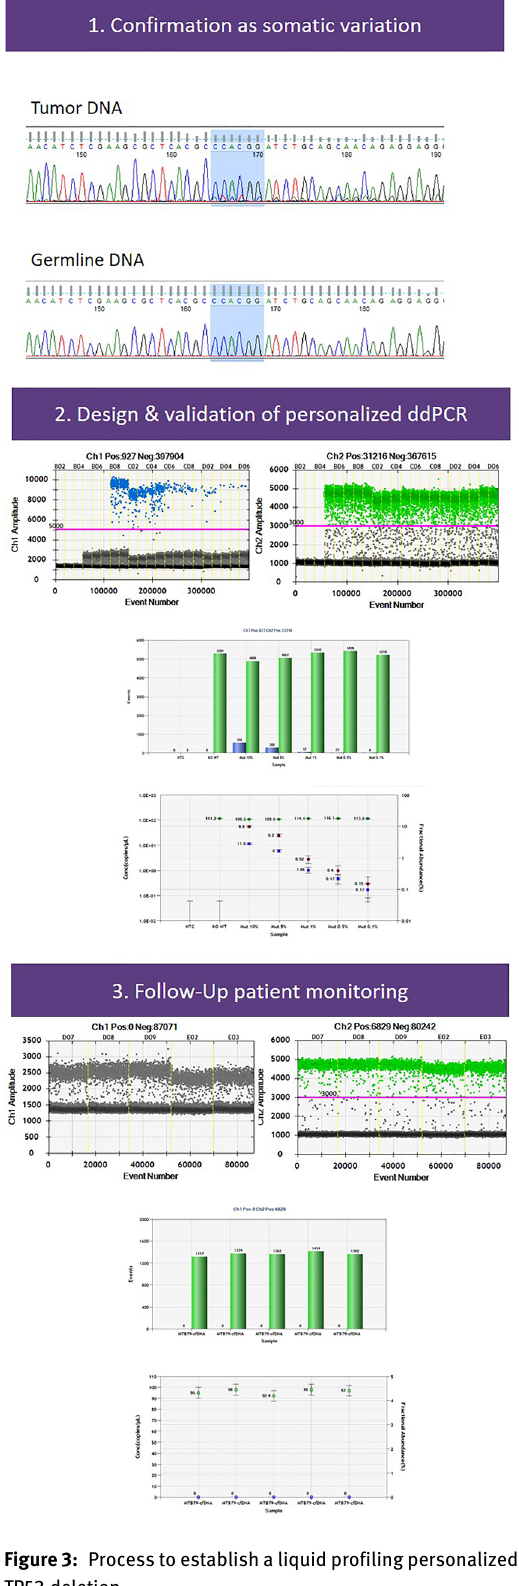
Figure 3: Process to establish a liquid profiling personalized assay: TP53